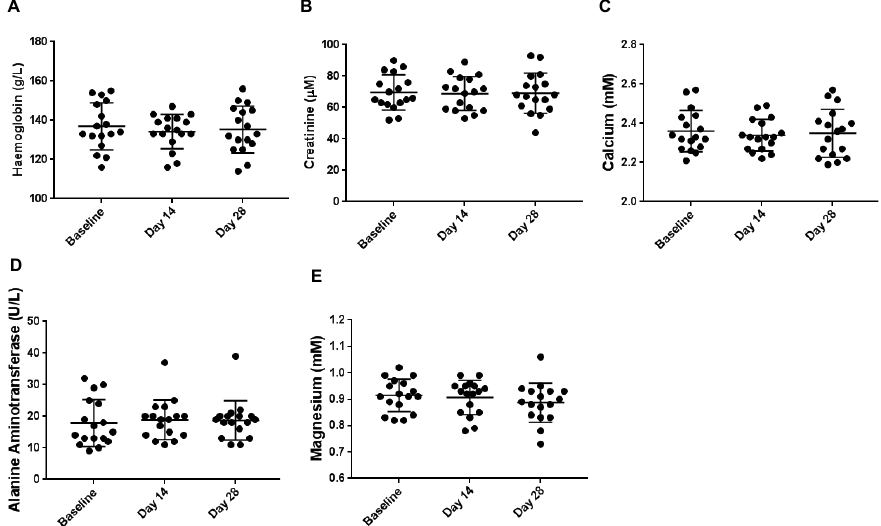
Figure 2. Haematological measurements for ( A ) haemoglobin, ( B ) creatinine, ( C ) calcium, ( D ) alanine aminotransferase and ( E ) magnesium. Each point represents a healthy participant with the midline and standard deviations plotted. 1way ANOVA tests of significance were performed across all time points, and no significance was observed.